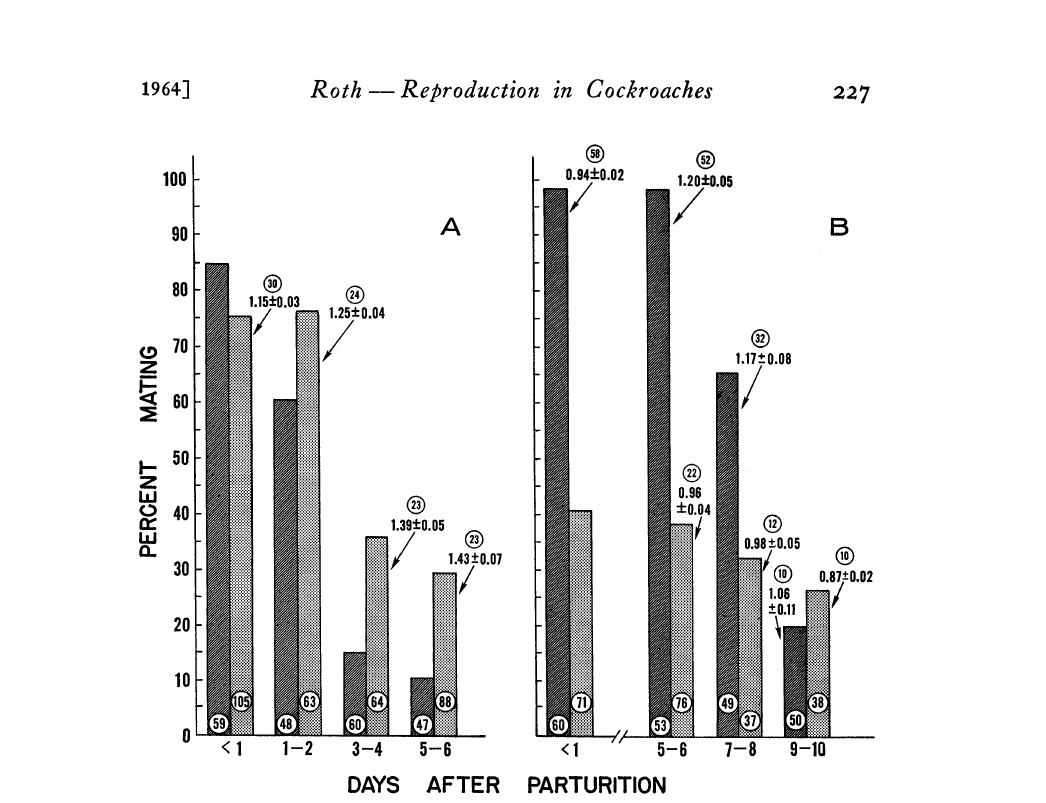
Fig. 16. Effect of starvation and delayed exposure to males on receptivity of females f.ollowing parturition in N. cinerea. A--Fed during gestation. Bin Starved during gestation. The axis of abscissas indicates the days after parturition females were placed with males. Lined bars fed after parturition. Stippled bars starved after parturition. Numerals in circles within the bars number of females used. Numerals opposite the bars = length of o/Scytes (ram.) _+ standard errors of females that mated, measured at the time of, or <24 hr. after copulating; numerals in circles outside the bars number of females whose ofcytes were measured. Gestation period of all the females was 35-40 days. Females fed during gestation and those starved during gestation but fed after parturition were kept with males until they mated or oviposited. Females starved during gestation and after parturition were allowed up to 10 days after parturition to